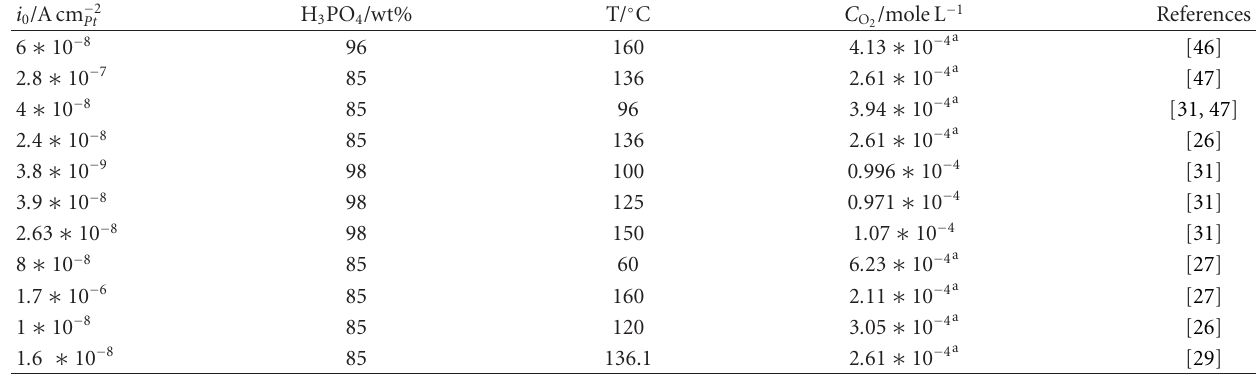
Table 2: Reported exchange current densities for oxygen reduction in phosphoric